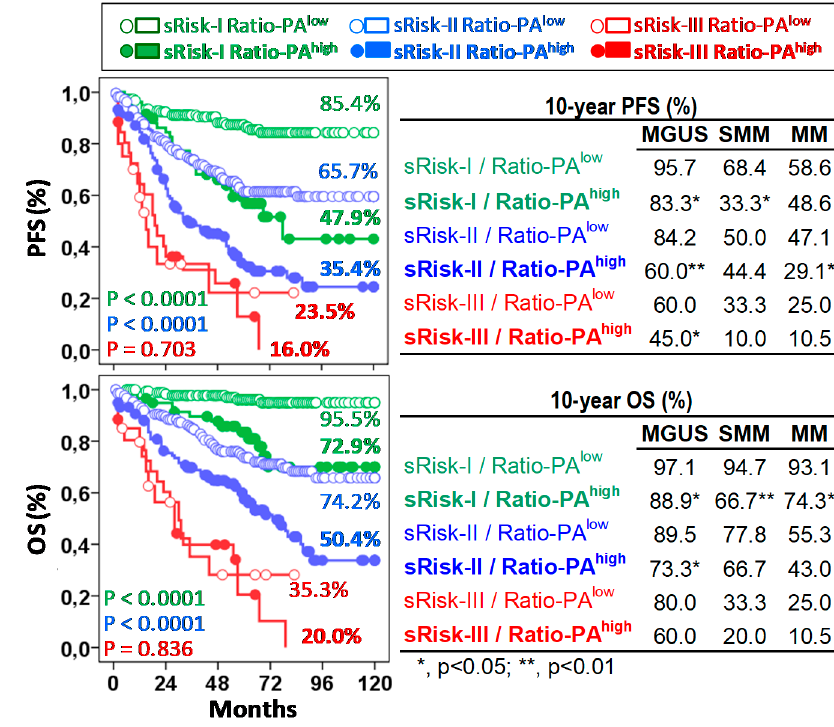
Figure 4. The Ratio-PA of bone marrow plasma cells complements standard risk stratification (sRisk). Left, Kaplan-Meier, and Log-rank tests for progression-free survival (PFS) and overall-survival (OS) of total patients according to Ratio-PA (high or low) in the standard risk groups (Risk-I, -II, and -III). Ten-year PFS and OS rates are indicated for each risk group in the plots. Tables on the right show same information for patients with monoclonal gammopathy of undetermined significance (MGUS), smoldering multiple myeloma (SMM), or multiple myeloma (MM). P estimated in the Log-rank test.